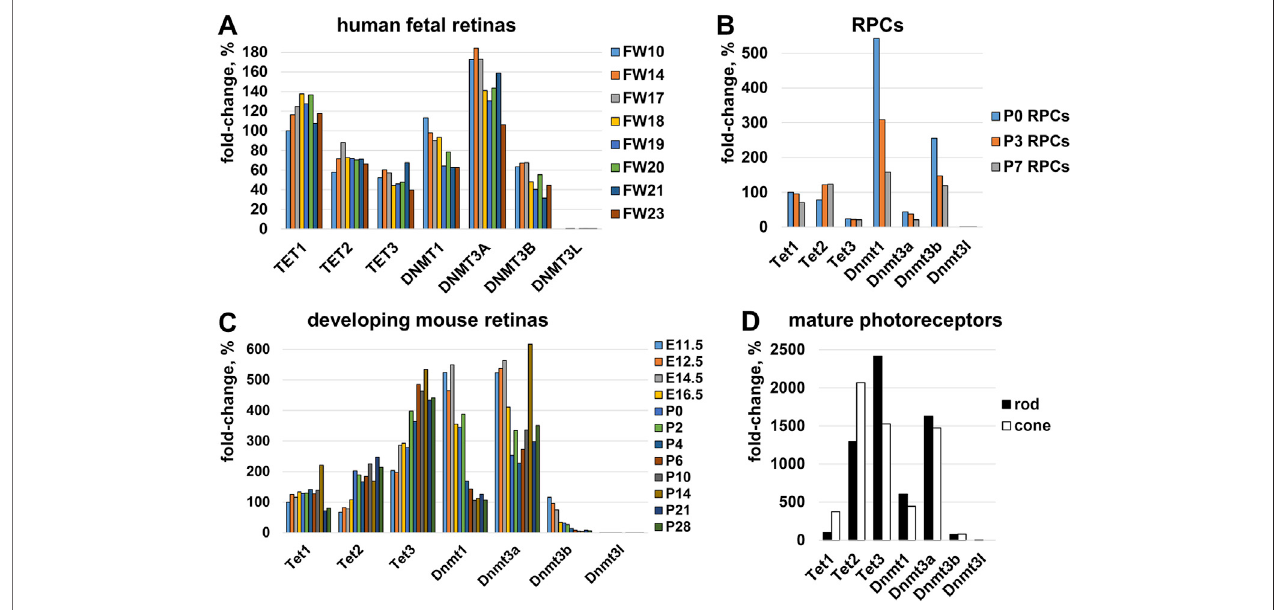
FIGURE7| TheexpressionofgenesbelongingtotheTETandDNMTfamilieswasevaluatedin (A) humanembryonicretinas(FW-fetalweek), (B) murineRPCs, (C) developing mouse retinas, and (D) mature rod and cone photoreceptors. For each gene, the results are expressed as a percentage of the corresponding values of Tet1 at the earliest time point in the studied